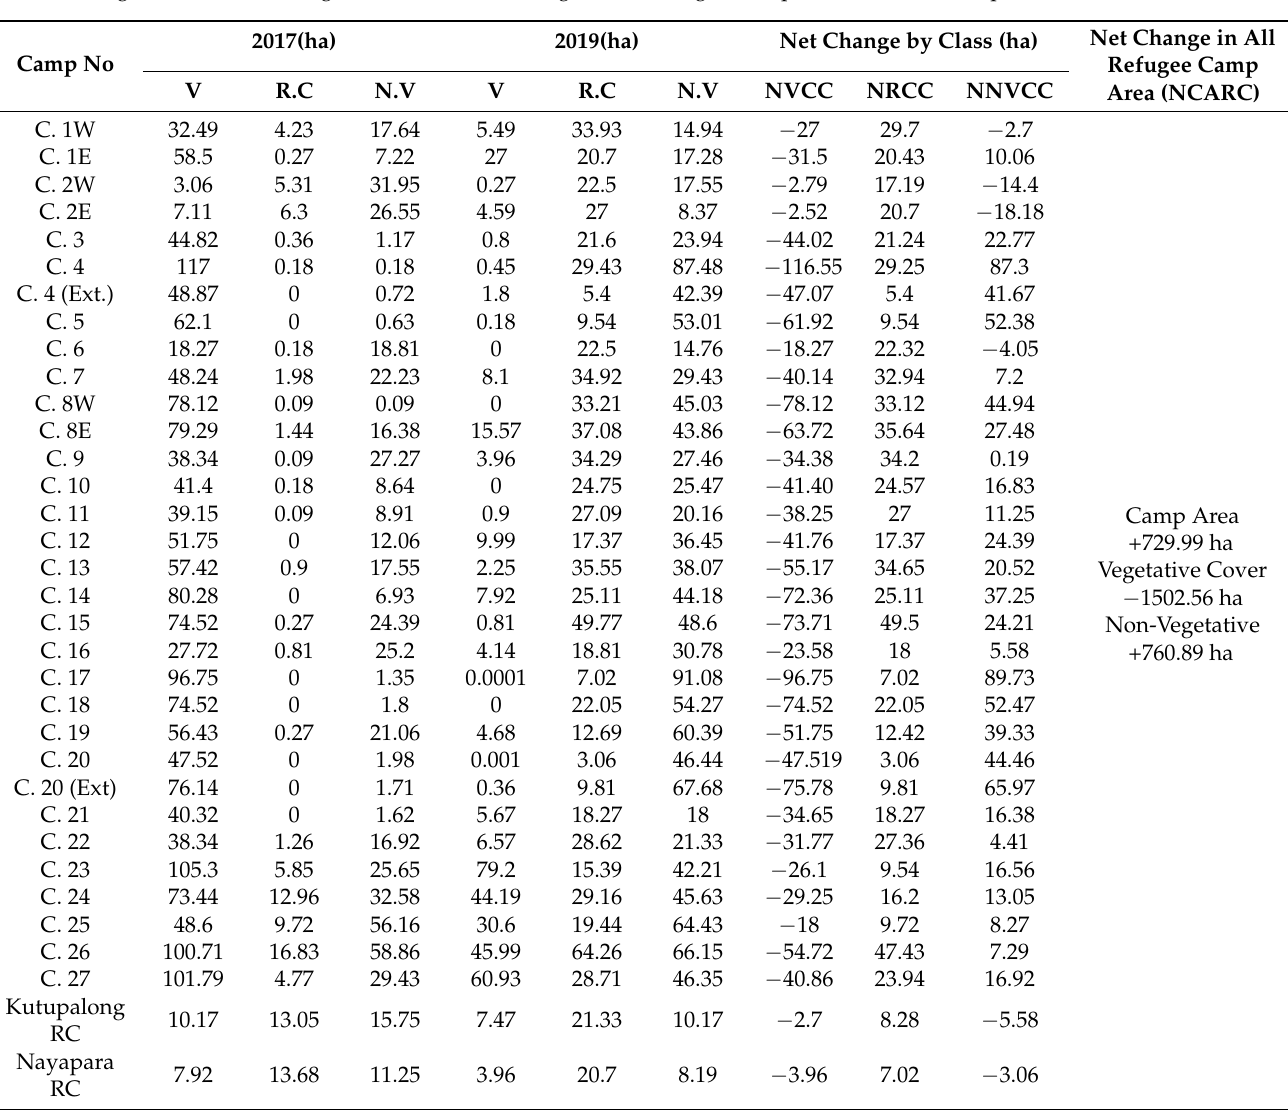
Table A1. Vegetative cover changes and overall net changes of different LULC area (hectares) in 2017, 2018, and 2019, among thirty-four Rohingya refugee camps, by the period of observation. Here, V = Vegetative, R.C = Refugee Camp, N.V = Non-Vegetative, NVCC = Net Vegetative Cover Change, NRCC = Net Refugee Camp Change, NNVCC = Net